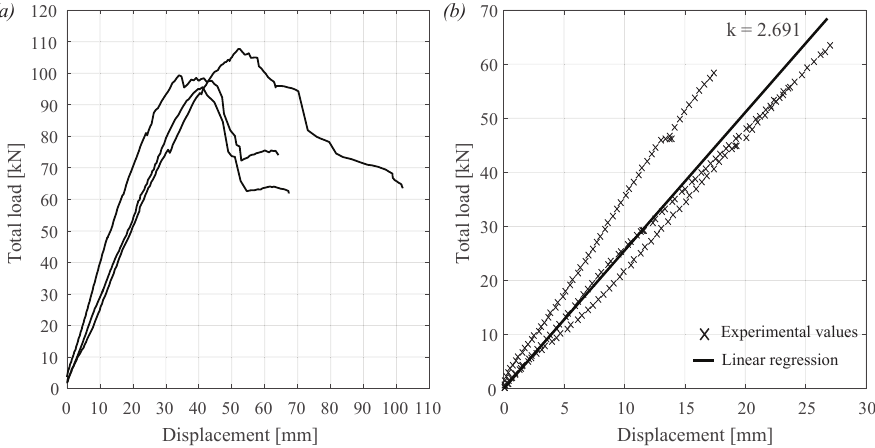
Figure 4. Total load vs. midspan deflection of the three replicates ( a ). Elastic part and stiffness, k , representing the entire group ( b